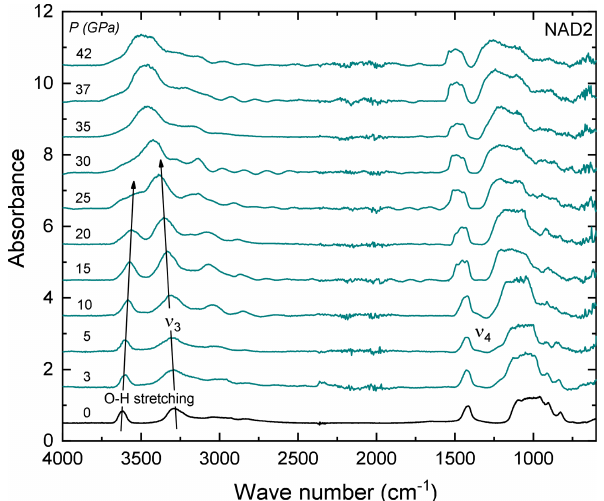
Figure 6. Some representative FTIR spectra of NH 4 -phengite (sam- ple NAD2) with increasing P at ambient T in a DAC, after the elimination of the interference fringes (see text). Arrows indicate the P -induced shift of the O–H stretching vibration to lower and − ν the NH + 3 to higher wave numbers with increasing P . At high 4 P s (above ∼ 25GPa), both peaks merge and form one broad peak and cannot be further distinguished. Spectra are vertically offset for